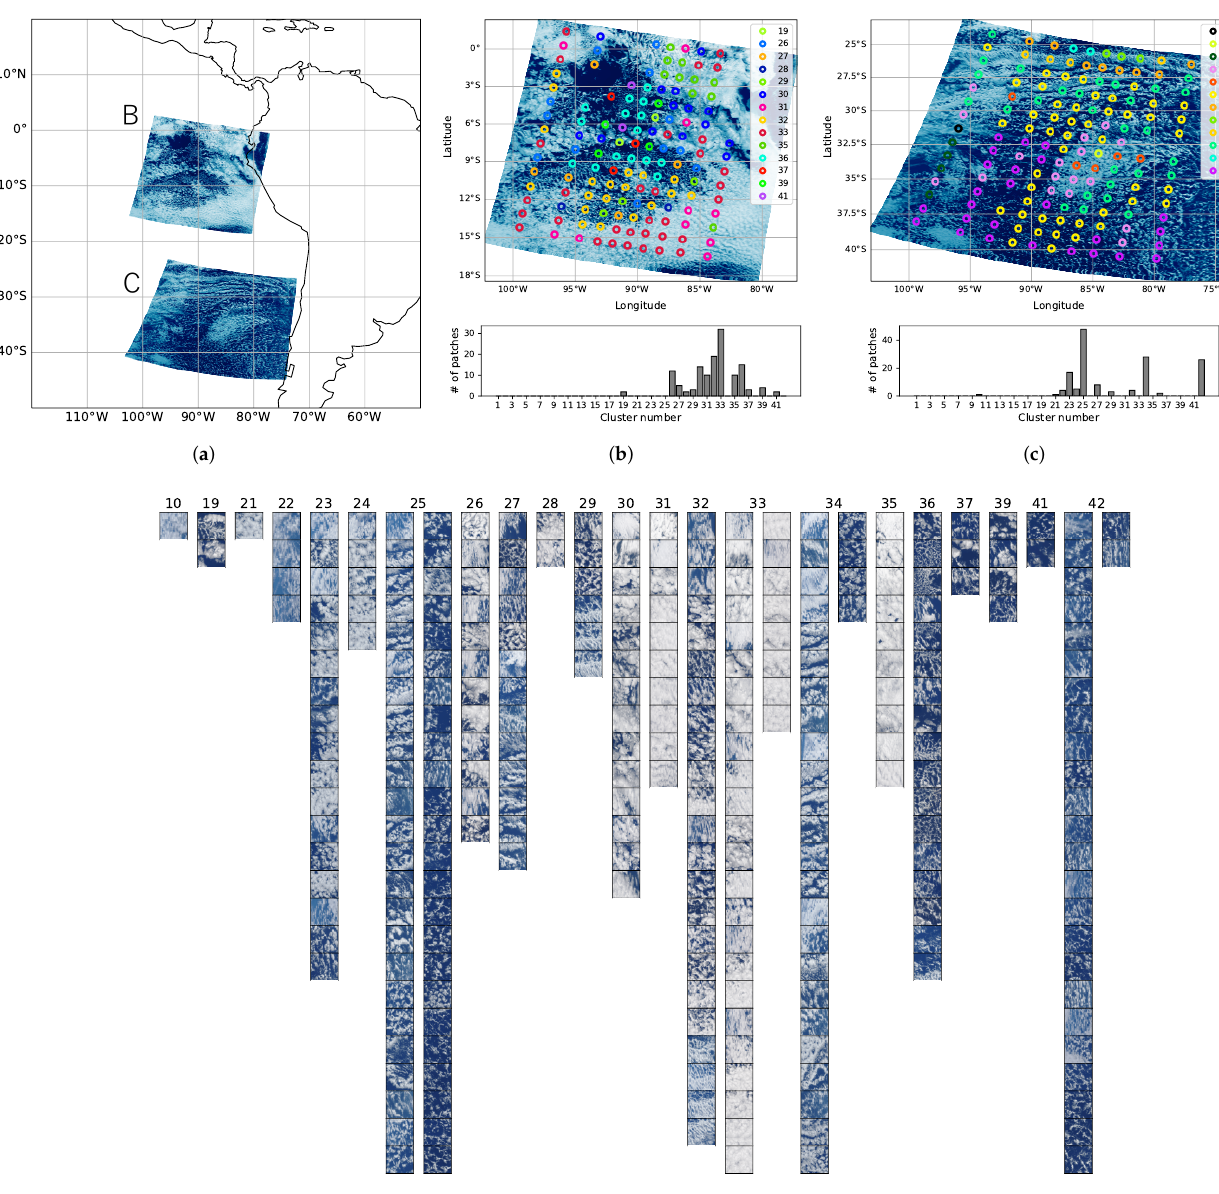
Figure 8. ( a ) Geographical location of two example MODIS swaths (B and C) off the west coast of South America, both from the Terra instrument but at different times; ( b ) Swath B, 133 ocean- cloud patches between 18 ◦ S to 3 ◦ N, 76 ◦ S to 104 ◦ S, observed on 15 January 2003, with each patch represented by a dot with color indicating its associated class label in the range 1..42; ( c ) Swath C, 147 ocean-cloud patches between 44 ◦ S to 23 ◦ S, 72 ◦ S to 103 ◦ S, observed on 20 July 2003, similarly labeled. Note that not all clusters appear in each swath. Histograms in ( b , c ) show the distribution of cloud class labels; note there is little overlap; ( d ) MODIS true color images [52] for all ocean-cloud patches labeled in ( b , c ), grouped by cluster number. Note the visual similarity of cloud textures within each cluster. AICCA 42 produces spatially coherent cluster assignments, groups visually similar textures, provides rich detail by subdividing stratocumulus clouds into multiple classes, and identifies subtle spatial and/or temporal